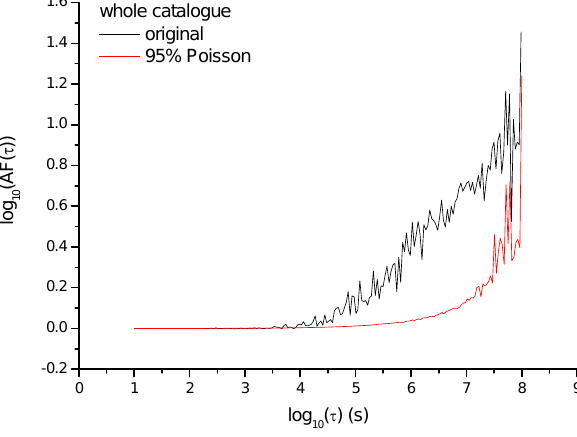
Fig. 5. Allan Factor curve for the full catalogue. Fig. 6. Comparison between the AF curve for the full catalogue (black line) and the 95% confidence curve (red line) obtained by means of generation of 1000 Poissonian sequences.